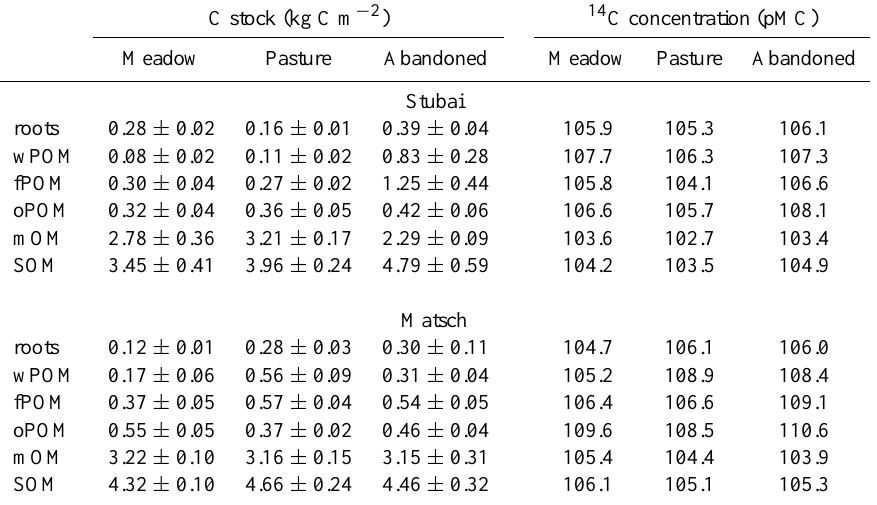
Table 2. C stocks, 14 C concentrations for roots, SOM fractions and bulk SOM of meadow, pasture and abandoned grassland at the Stubai and Matsch site. For C stocks mean and standard error of 4–6 replicates is shown. The AMS precision (1 σ ) for 14 C concentrations is ± 0.4 pMC.